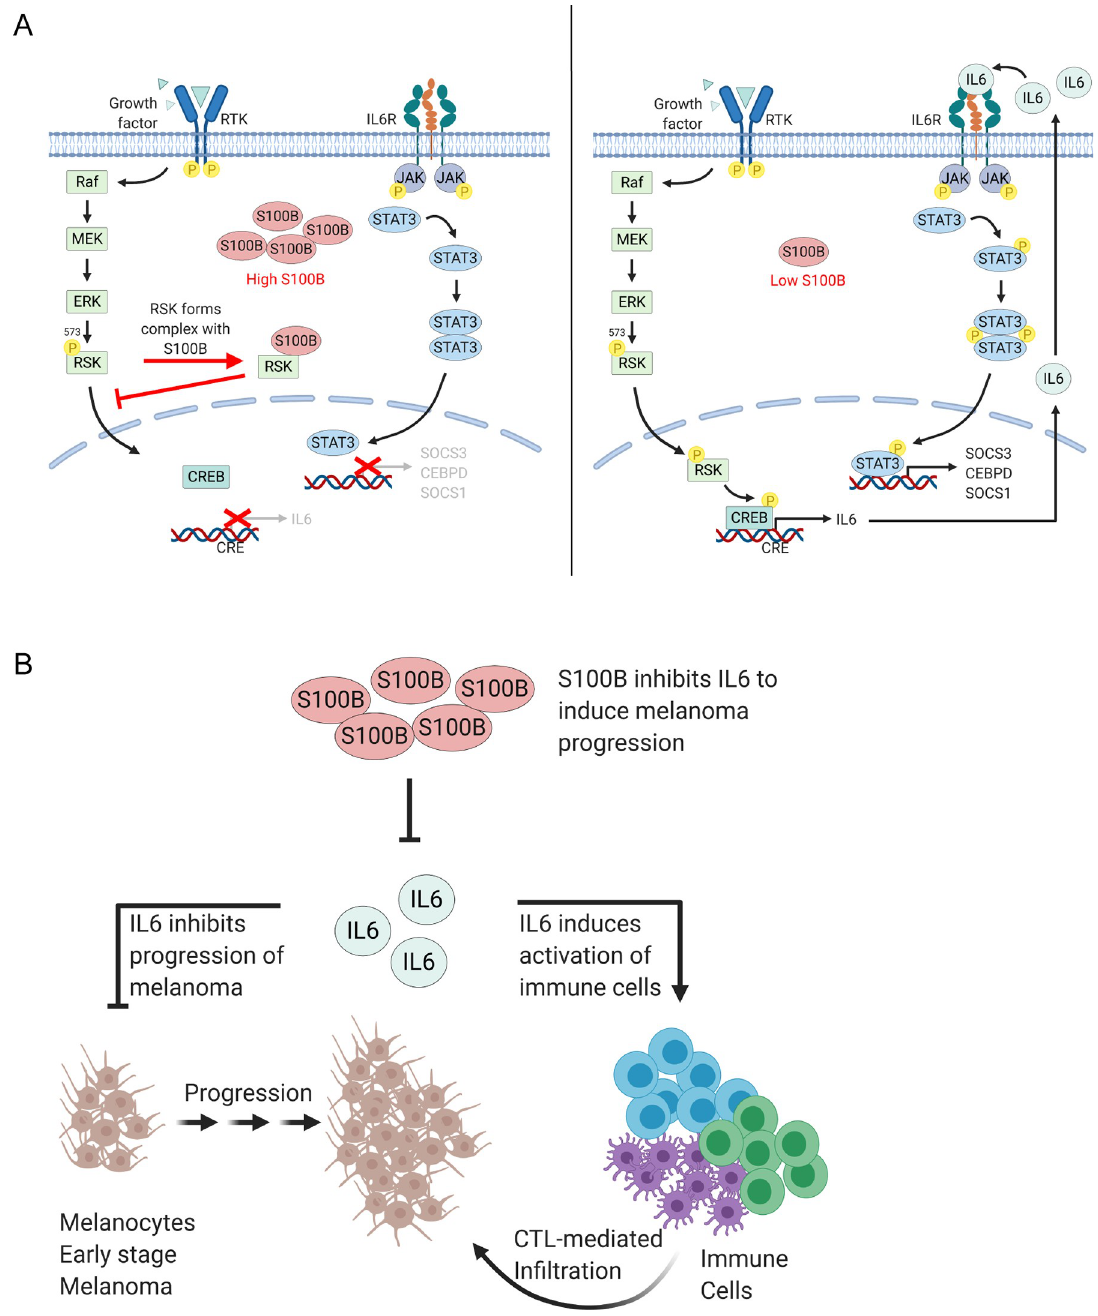
Fig 7. Model for S100B-dependent inhibition of IL6/STAT3 signaling and its possible role in the pathology of malignant melanoma. (A) Elevated levels of S100B found in most melanoma binds RSK in a calcium-dependent manner and sterically prevents its ERK-dependent phosphorylation at T573, which is needed for RSK nuclear localization (8). As a result, it is proposed here that elevated S100B inhibits expression and secretion of IL6 and phosphorylation and transcriptional activity of STAT3 (Figs 1–4). S100B-dependent inhibition of IL6 and STAT3 phosphorylation is via RSK (Fig 5). S100B also inhibits phosphorylation of CREB in the nucleus. Given that S100B forms a complex with RSK and prevents RSK nuclear localization, it is proposed that S100B inhibits phosphorylation of CREB in the nucleus via RSK (Fig 6). Thus, CREB-dependent expression of IL6 is inhibited, as is IL6/STAT3 signaling. (B) During early stages of melanoma progression, it is hypothesized that IL6 induces anti-proliferative mechanism to inhibit the progression of melanoma. Thus, when S100B levels elevate to a critical threshold in a pre-metastatic state, it blocks IL6 expression and initiates the transition of melanoma from pre-malignant to a malignant form.